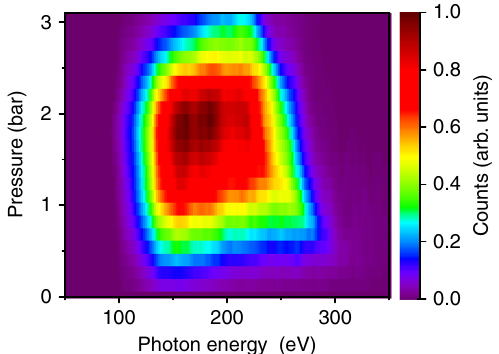
Fig. 2 Pressure-dependent soft X-ray yield. Soft X-ray continua generated by polarization gating as a function of pressure in the neon gas cell. The spectra were recorded by an electron TOF spectrometer and corrected for the photoionization potential (21.6 eV) and absorption cross section of the neon detection gas. Photons with energy < 100 eV were fi ltered out using a 100 nm tin fi lter